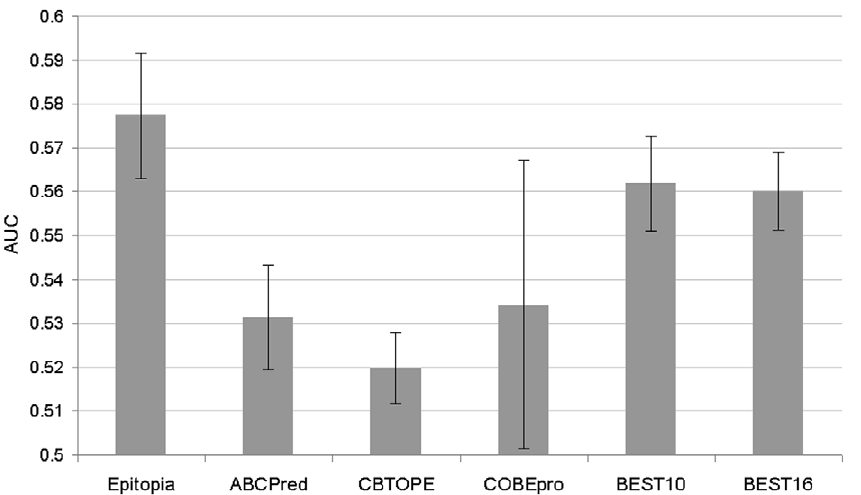
Figure 5. The average AUC values estimated using SEQ194 dataset. The values were calculated over the 10 repetitions using 100 randomly selected chains from the SEQ194 dataset (shown using gray bars) and the corresponding standard deviations (shown using black error bars) for the considered B-cell epitope predictors.